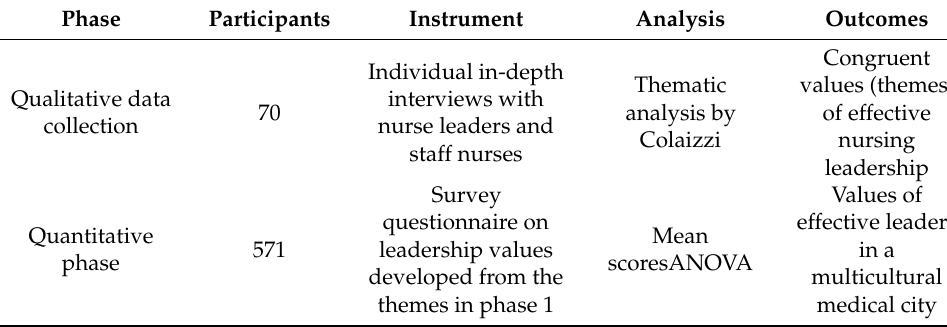
Table 1. Sequential mixed-methods design of the